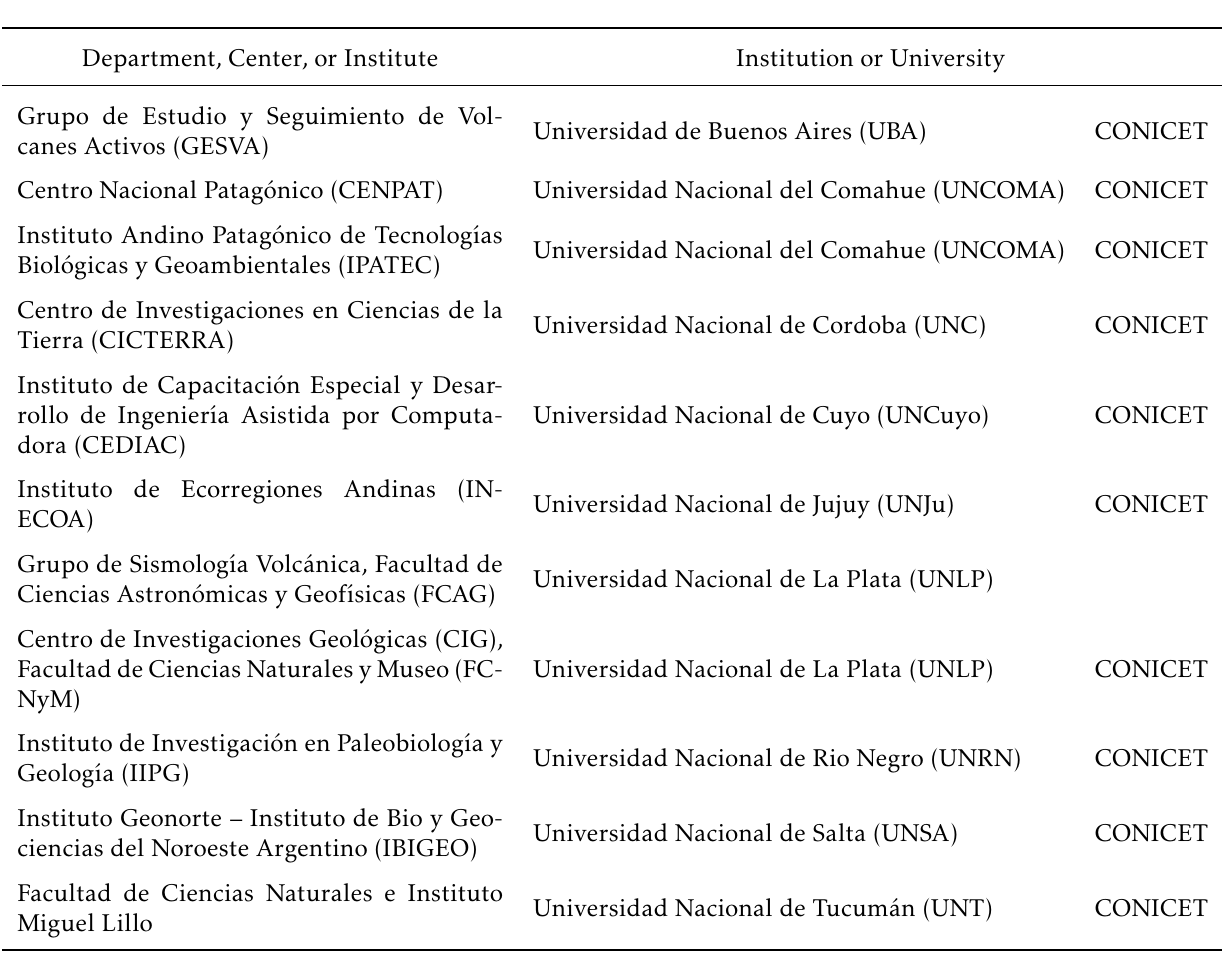
Table 1: Some of the research groups, centres, or university institutes or mixed dependency (University and Con- sejo Nacional de Investigaciones Científicas , CONICET) that have historically carried out volcano monitoring and volcanological